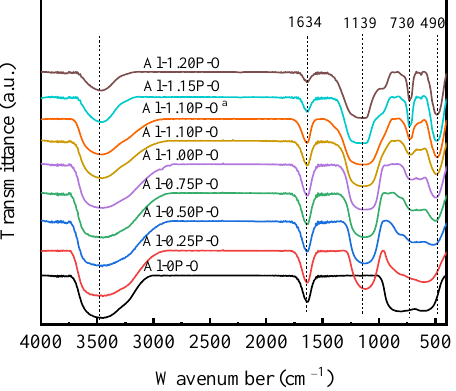
Figure 4. FT-IR spectra of Al- x P-O and Al-1.1P-O a samples. NH 3 -TPD profiles and surface acidic and basic parameters of Al- x P-O and Al-1.1P- O a samples are displayed in Figure 5a and Table 1. All samples had a desorption peak between 100 and 250 °C, indicating the existence of weak acid sites [38]. The desorption peaks shifted to lower NH 3 desorption temperature with the increasing P/Al molar ratio, indicating that the addition of P weakened the strength of the acid site. The area of the NH 3 desorption peak increased when the P/Al molar ratio increased from 0 to 0.75. With the increase of the P/Al molar ratio to 1.10, the area of the NH 3 desorption peak decreased slightly. However, when the P/Al molar ratio further increased to 1.15 and 1.2, a sudden decrease of the area of the NH 3 desorption peak appeared, indicating that the number of acid sites of catalysts with higher P/Al molar ratio ( x ≥ 1.15) was very low. It could be speculated that the P-OH group was the main source of the weak acid center. The catalyst with the higher P/Al molar ratio (P/Al > 1.1) eased the formation of aluminum phosphate crystal phase, resulting in a low number of acid centers. Compared with the Al-1.1P-O sample, Al-1.1P-O a had a lower NH 3 desorption temperature and a smaller area of NH 3 desorption peak, proving that P123 addition could boost the formation of stronger acid sites. ( a ) ( b ) Figure 5. ( a ) NH 3 -TPD and ( b ) CO 2 -TPD profiles of Al- x P-O and Al-1.1P-O a samples.